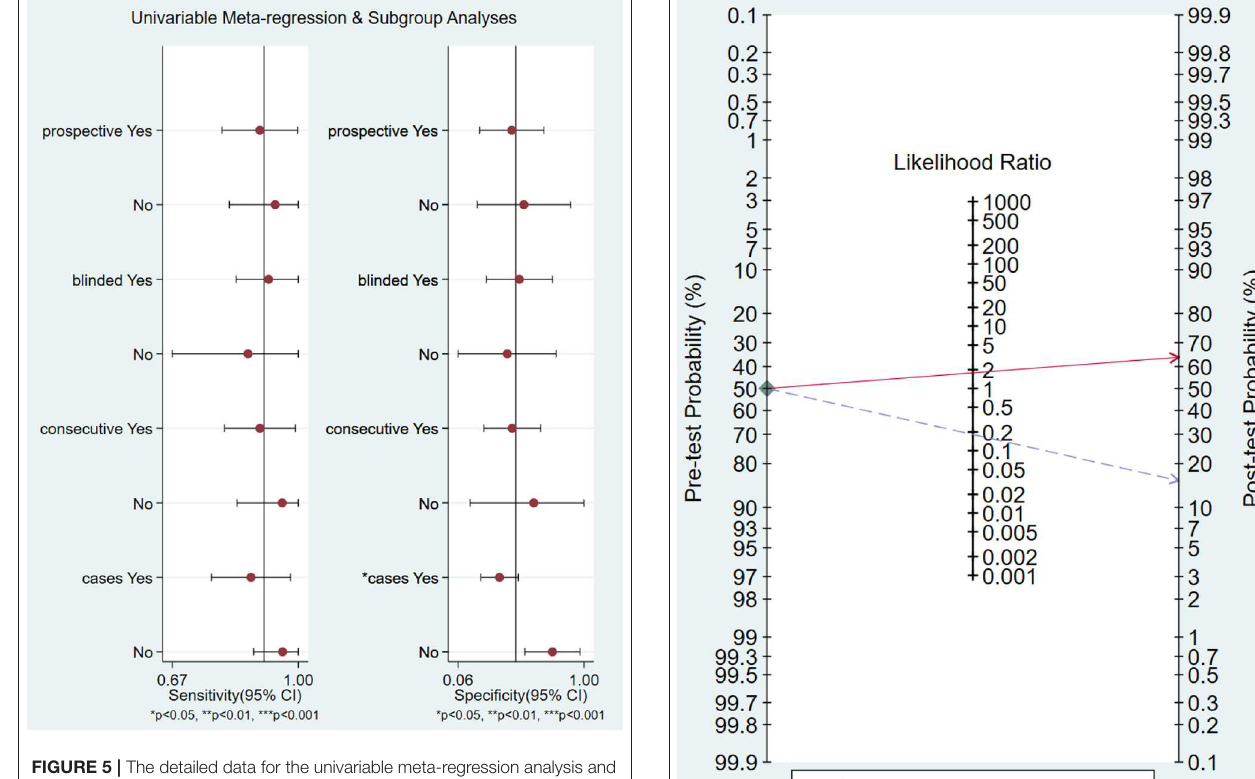
were 0.30, 0.26, and 0.23, respectively (14, 16, 19). Astobieta et al.